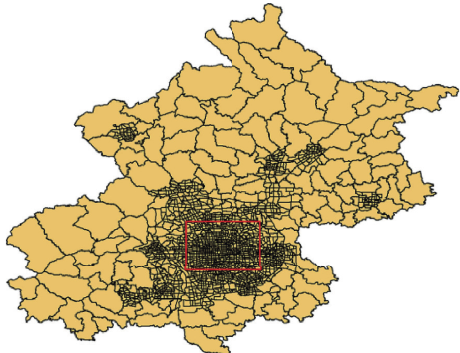
Figure 1: Traffic analysis zones in Beijing.